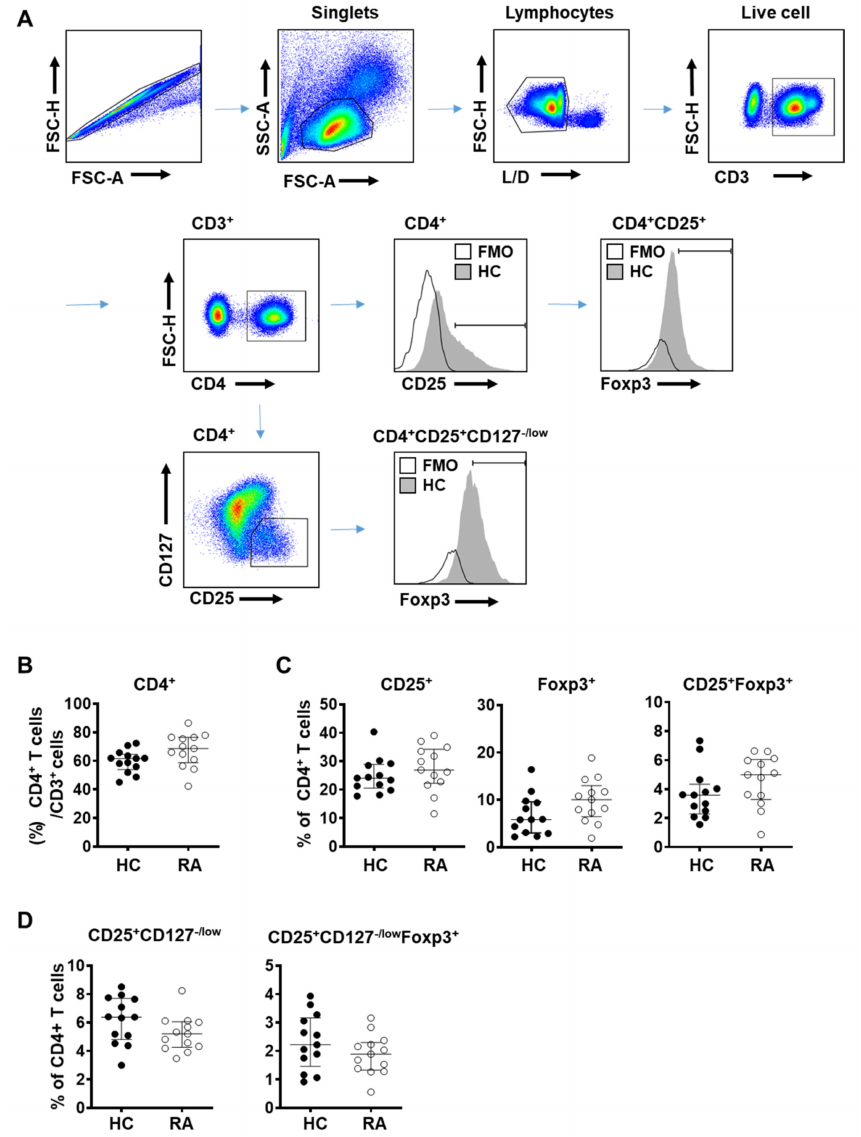
Figure 1. Frequency of regulatory T (T reg ) cells did not change in patients with rheumatoid arthritis (RA). Blood samples were collected from healthy donor (HC, n = 13) and rheumatoid arthritis patients (RA, n = 13) and analyzed by flow cytometry. ( A ) Flow cytometry gating scheme of T reg subpopulations in human peripheral blood mononuclear cells (PBMC). FMO (fluorescence minus one control); HC (healthy control). Percentage of ( B ) CD4 + T cells among CD3 + T lymphocytes in PBMC, ( C ) CD25 + , Foxp3 + , or CD25 + Foxp3 + T reg cells among CD4+ T cells, and ( D ) CD25 + CD127 − /low , or CD25 + CD127 − /low Foxp3 + T reg cells among CD4 + T cells. Data from individual subjects were presented with the median values. Statistical differences were calculated by Mann–Whitney